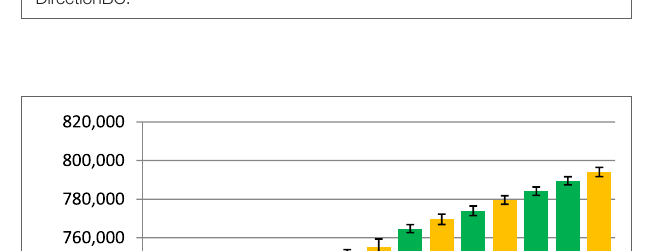
FigUre 7 | Final QD-score (asymmetric gauntlet) . The QD-score achieved by each of fifteen treatments ( Table 2 ) after 1,000,000 evaluations on the asymmetric gauntlet is shown (averaged over 20 runs). Bars are color coded according to which BC drives search (see section 6) and error bars represent SE. In all cases, QD-score is measured with respect to DirectionBC.